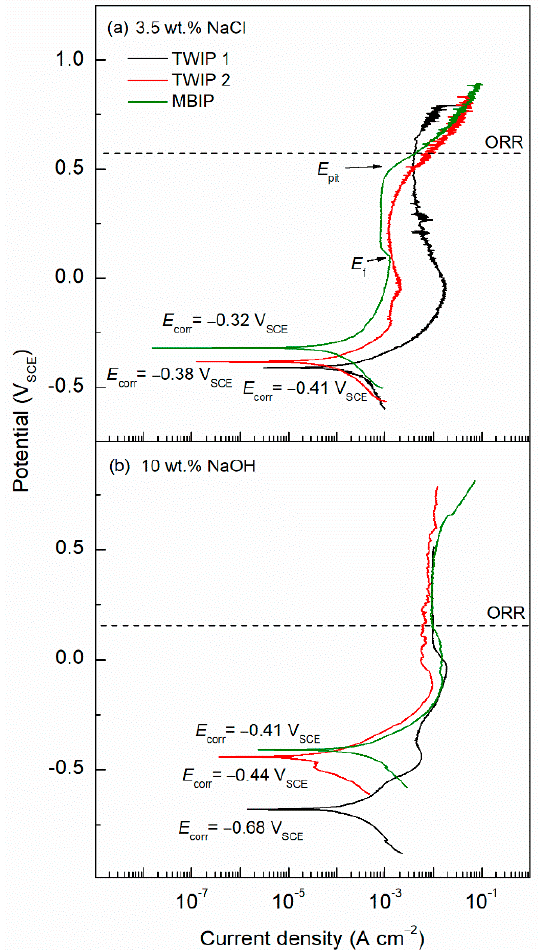
Figure 7. Polarization curves for two TWIP steels (Fe − 22.6Mn − 6.3Al − 3.1Cr − 0.68C and Fe − 28Mn − 5.2Al − 5.1Cr − 2.8Si − 0.95C) and a microband-induced plasticity (MBIP) steel (Fe − 30Mn − 8.5Al − 3.2Cr − 1.1Mo − 1.0C) in: ( a ) 3.5 wt.% NaCl solution, and ( b ) 10 wt.% NaOH solution [88].